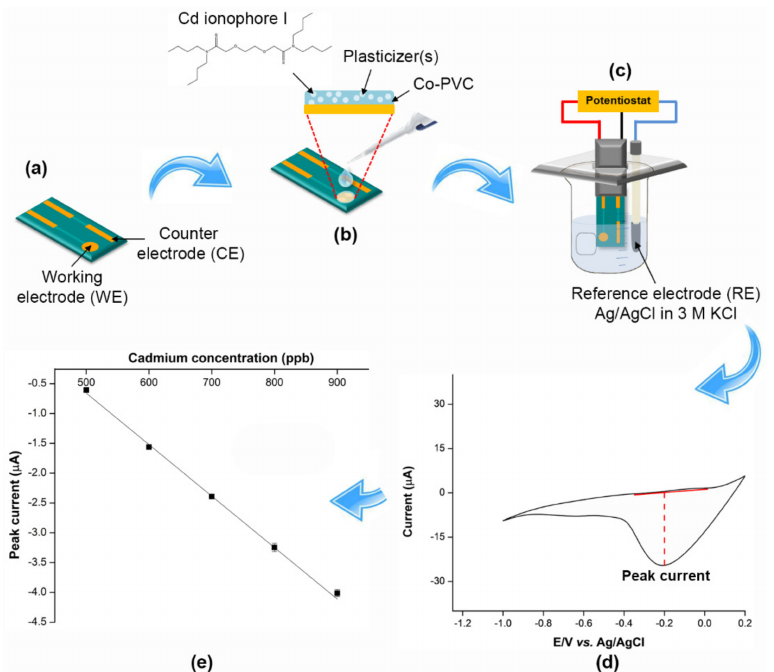
Figure 1. SPGE-based cadmium sensor development and voltammetric measurement. ( a ) SPGE containing working electrode (WE) and counter electrode (CE), ( b ) gold surface of working electrode was modified with membrane solution composed of co-PVC, plasticizers and cadmium ionophore I for cadmium(II) detection, ( c ) modified SPGE was connected to potentiostat and external referent electrode (Ag/AgCl in 3 M KCl), ( d ) the voltammogram representing the peak current of the sensor, and ( e ) linear current response observed from peak current of voltammogram.